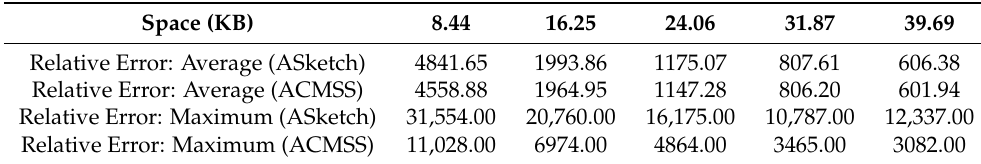
Table 4. Relative Error: Average and maximum, zipfian distribution with skew ρ = 1.3 and support threshold φ = 0.002.